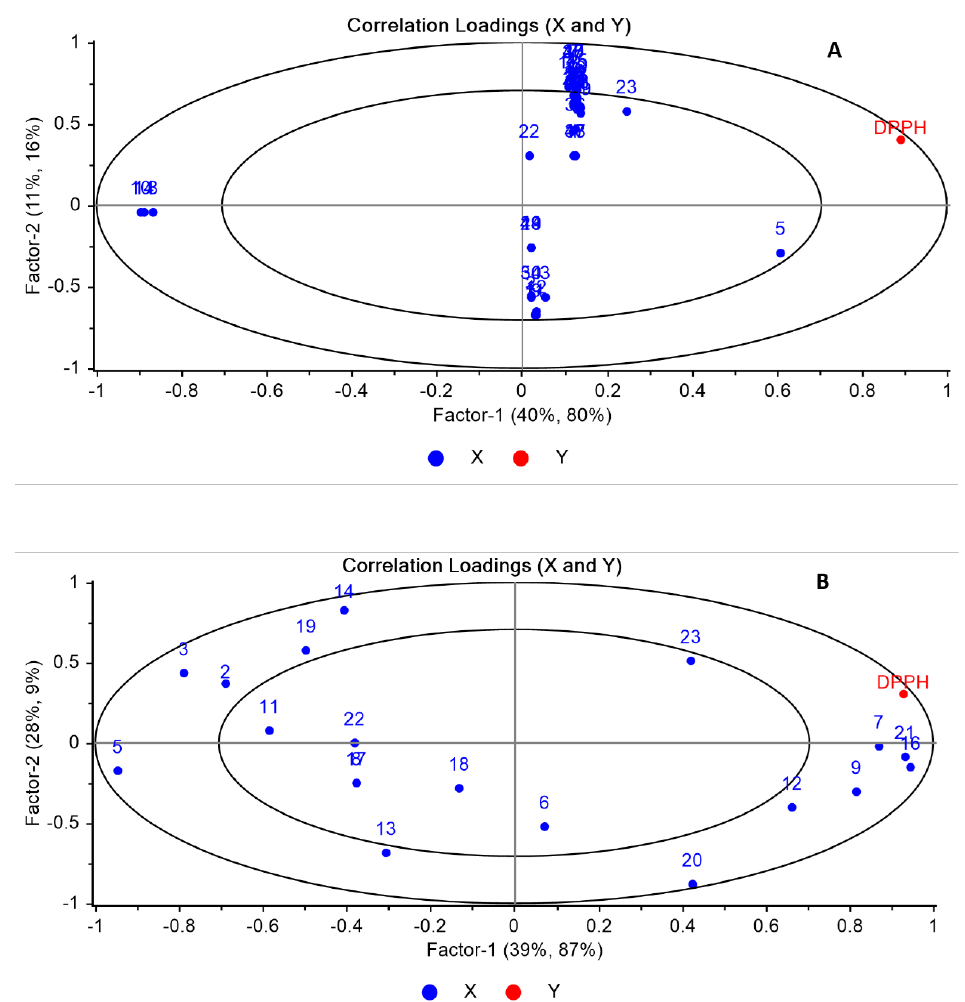
Figure 5. Correlation loading plot ( A ) PLS-R1 for GC-MS data (X matrix) and antioxidant activity (Y matrix), ( B ) PLS-R2 for HPLC data (X matrix) and antioxidant activity (Y matrix). Please refer to Tables 1 and 3 for compound numbers.